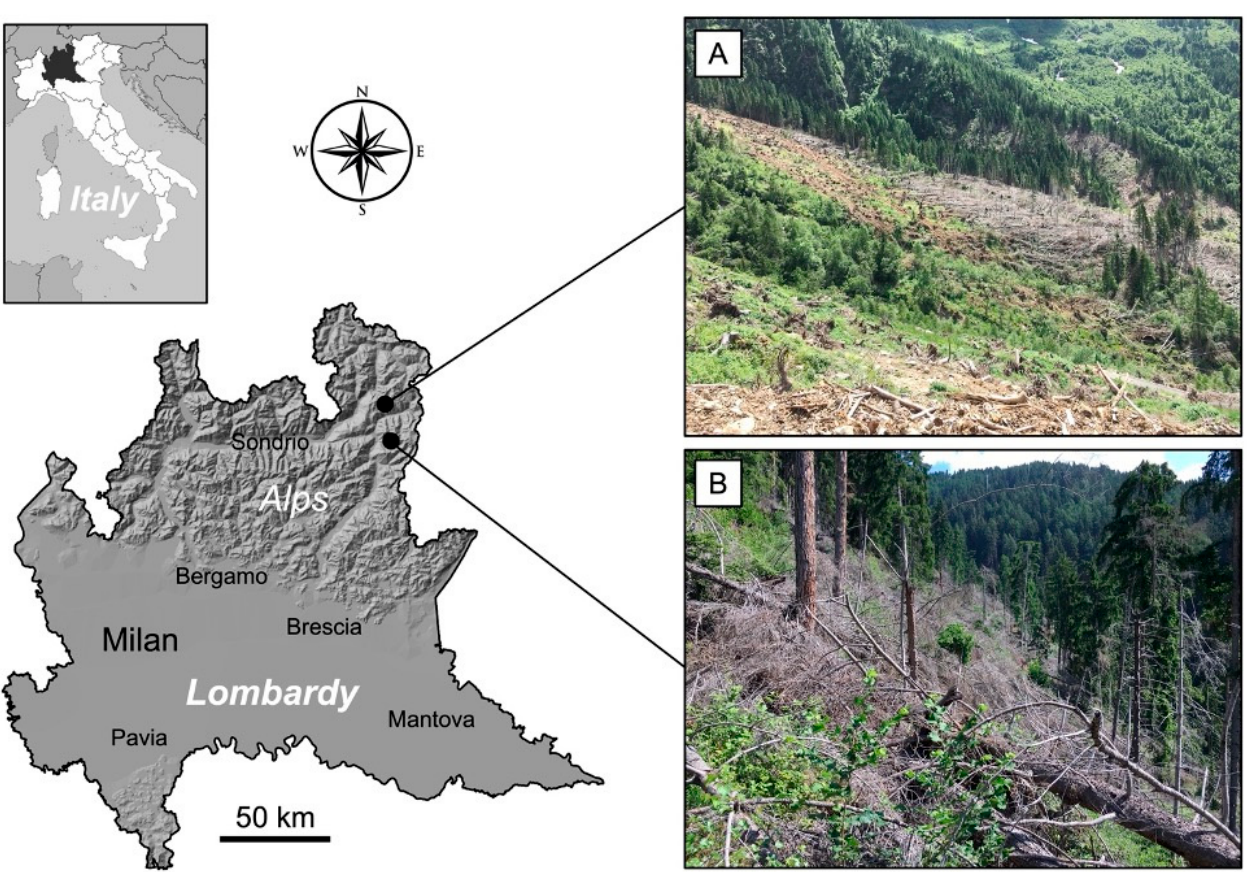
Figure 1. Location of the two study areas: Val Malga ( A ) and Vione ( B ). The photographs show the areas in July 2021.